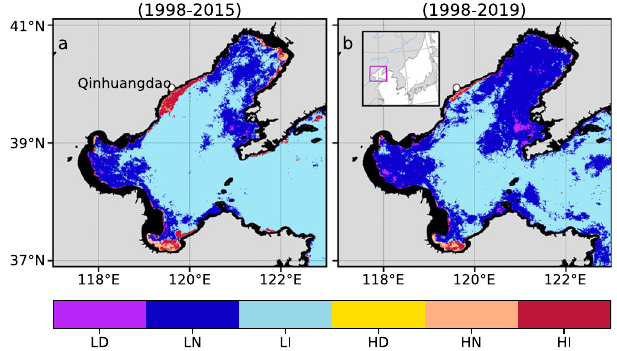
Fig. 1 Map of coastal eutrophication potential (CEP) in the Bohai Sea. LD, LN, and LI depict the status as being low CHL ( α < 5 mg m − 3 ) with decreasing trend, no trend and increasing trend, respectively. HD, HN and HI indicate high CHL ( α ≥ 5 mg m − 3 ) with the three above-mentioned trends, respectively. a Preliminary assessment of CEP for the period 1998 – 2015. b Same as a but for the period 1998 – 2019. The rectangle in magenta ( b ) shows the location of